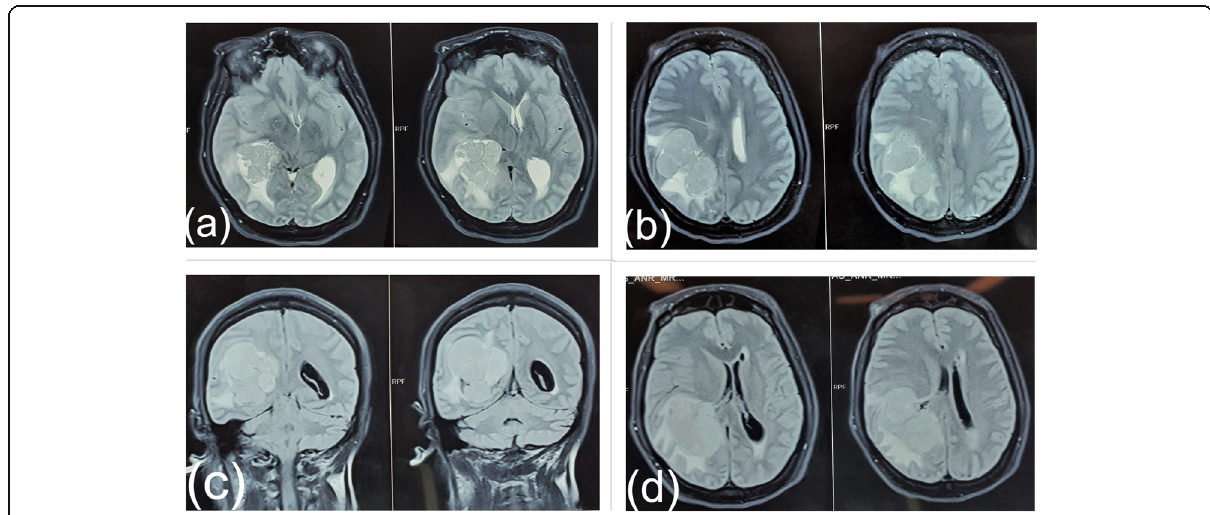
Fig. 1 a , b MRI scan brain T2WI axial image shows large trigonal meningioma. c , d Brain MRI FLAIR image shows trigonal meningioma